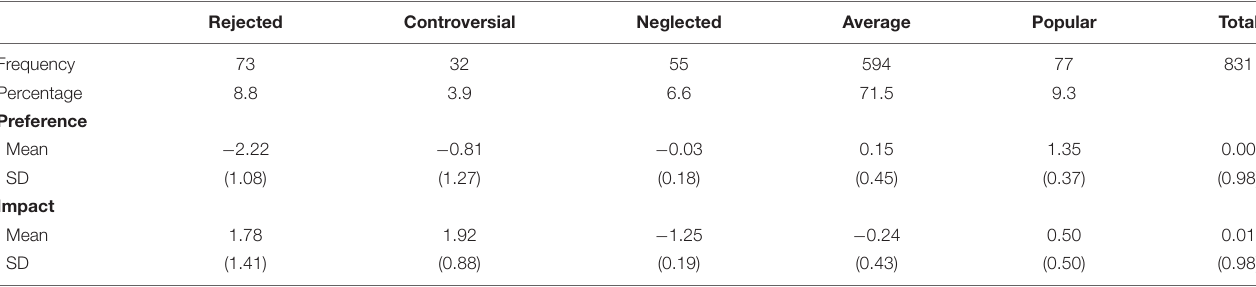
TABLE 3 | Personal and socio-family characteristics of the sociometric status. Rejected Controversial Neglected Average